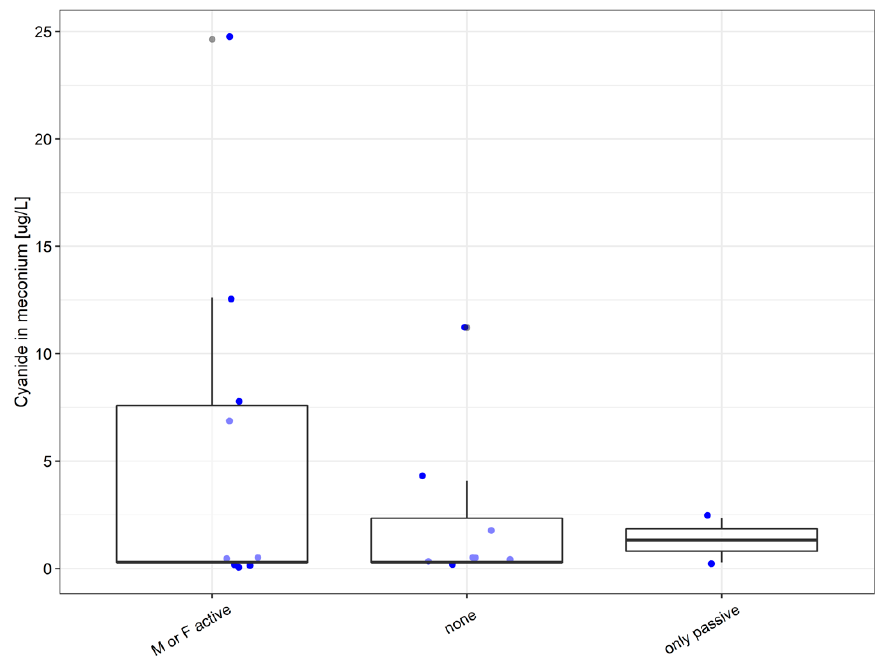
Figure 3. Smoking habits of the father or mother (F or M)—influence on the child’s meconium cyanide concentration. Differences between groups were not significant (Kruskal–Wallis ANOVA p = 0.76).